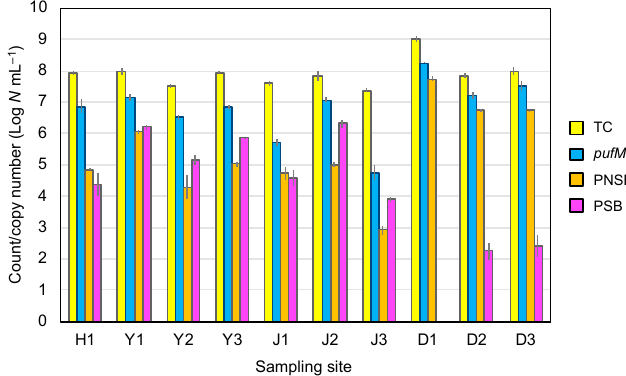
Figure 3. Direct total counts, pufM gene copy number, and viable counts of PNSB and PSB in colored blooms and mats in hot spring H1, mudflats (Y1–3), tide pools (J1–3), and wastewater ditches (D1–3). Color of histograms: yellow, direct total count; blue, pufM copy number; orange, PNSB viable count; purple, PSB viable count. The vertical bars show standard deviation ( n = 3).